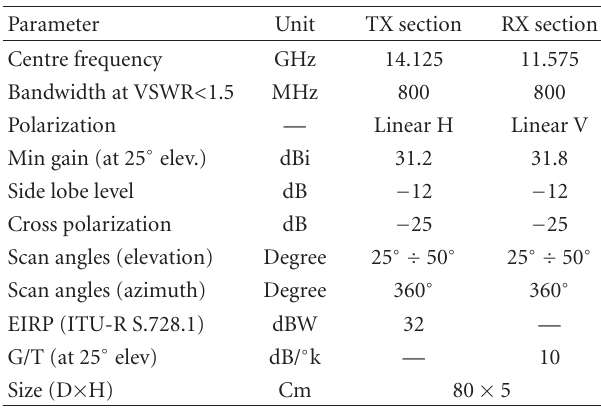
Table 1: Expected RX/TX antenna performance.